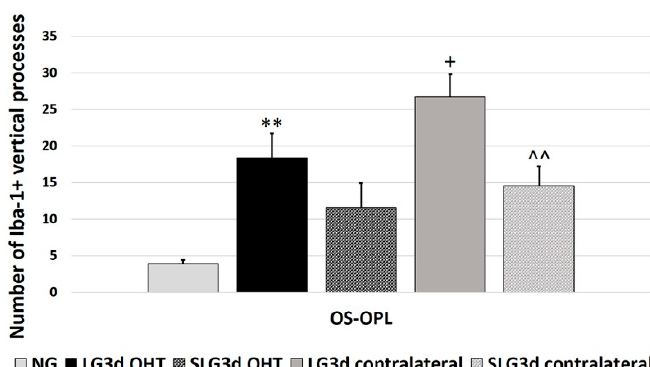
Figure 9. Comparison of Iba-1 + vertical processes (VP) in eyes untreated and treated with saffron extract at 3 days after ocular hypertension (OHT) induction. Histograms show the mean number (± standard deviation, SD) of Iba-1 + vertical processes. Abbreviations: Naïve age-matched control (NG), lasered group contralateral (LG3d contralateral), lasered group ocular hypertension (LG3d OHT), lasered group contralateral + saffron (SLG3d contralateral), lasered group ocular hypertension + saffron (SLG3d OHT). Statistical significance indicators: ** p < 0.01; vs . NG. + p < 0.05; vs. LG3d OHT. ^^ p < 0.01; vs. LG3d contralateral.